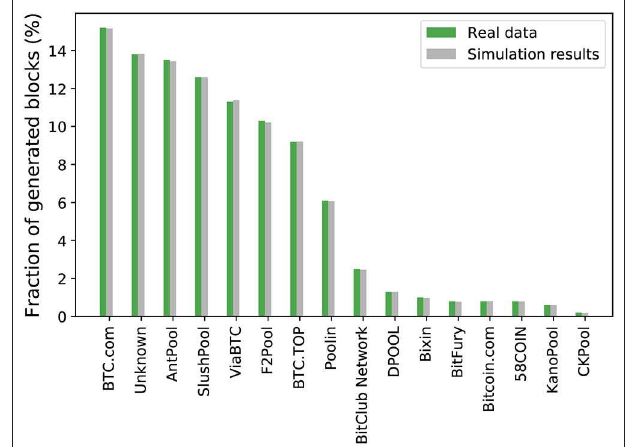
FIGURE 5 | Validation of PoW using the fraction of generated blocks given the hashing share of various